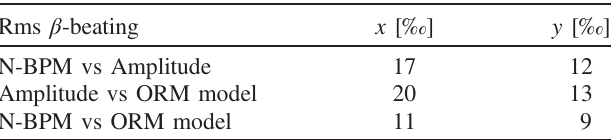
TABLE III. Measured β -beating between different